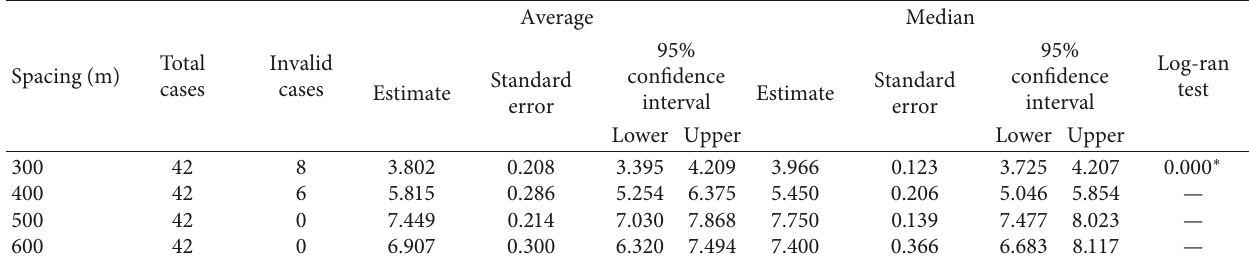
Table 4: Statistical results of MLCD under the influence of different